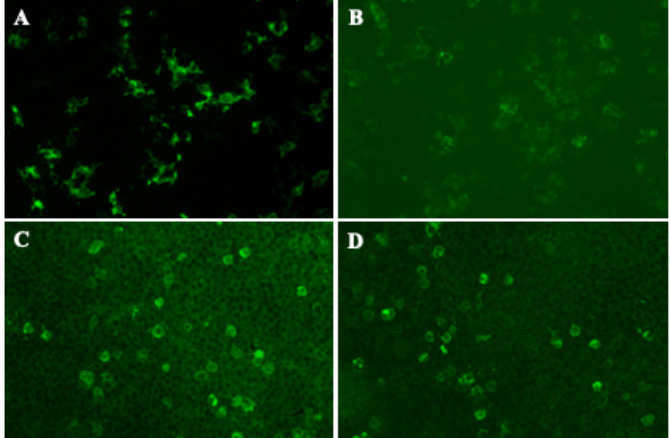
Figure 3. The repeat serum and CSF antibody tests for NF 155 and NF186 by CBA after 4 months follow-up visit. Anti-NF 155 IgG4 antibodies detected in the patient’s serum ( A ) (titer 1:1000) and CSF ( B ) (titer 1:10) using CBA method. Anti-NF186 IgG4 antibodies detected in the patient’s serum ( C ) (titer 1:1000) and CSF ( D ) (titer 1:10) using CBA method. CBA: cell-based assay; CSF: cerebrospinal fluid; Ig: immunoglobulin; NF: neurofascin.